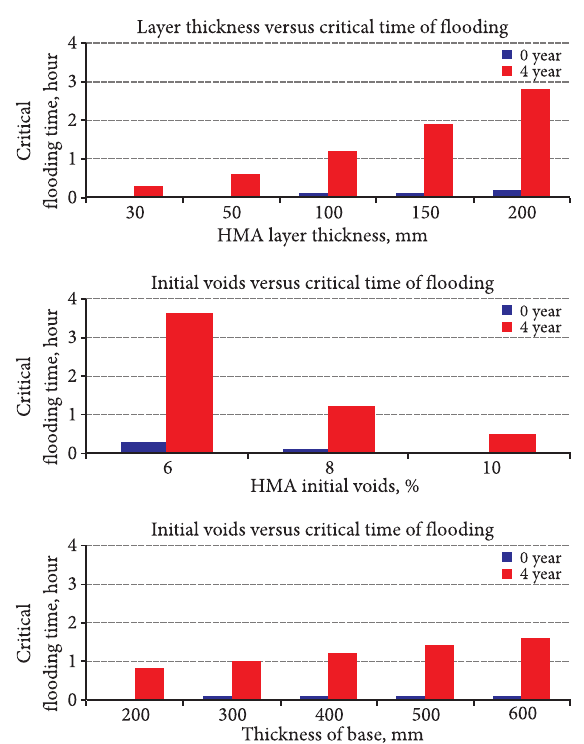
Fig. 3. Effects of various design and construction